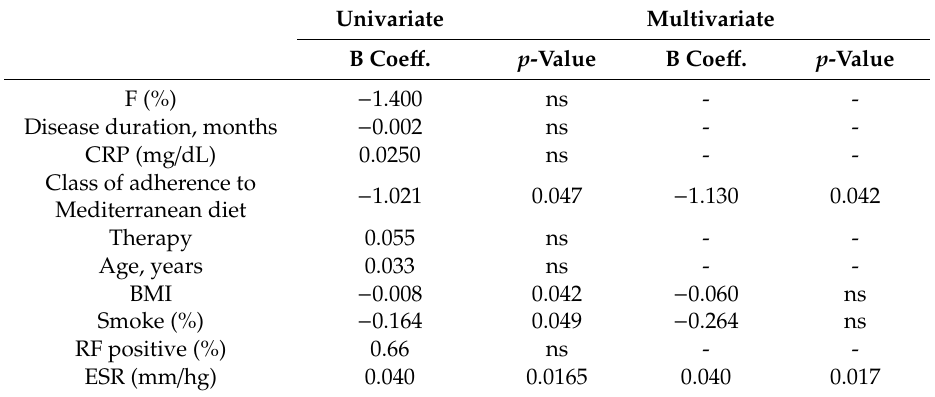
Table3. AssociationbetweentheclassofadherencetotheMediterraneandietandthemaindemographic, anthropometric and clinical parameters of the RA